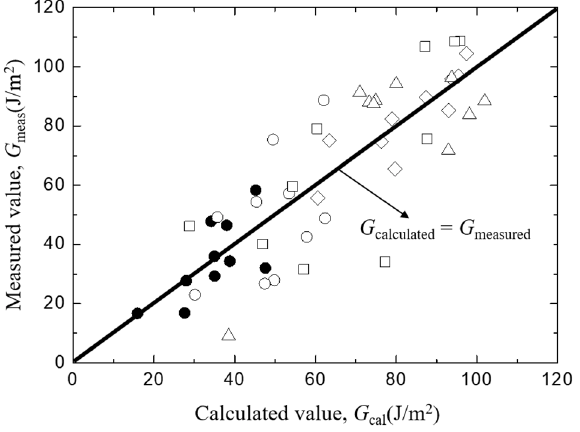
Figure 9. The comparison between measured and calculated interfacial fracture toughness of Typha spp. /Epoxy.